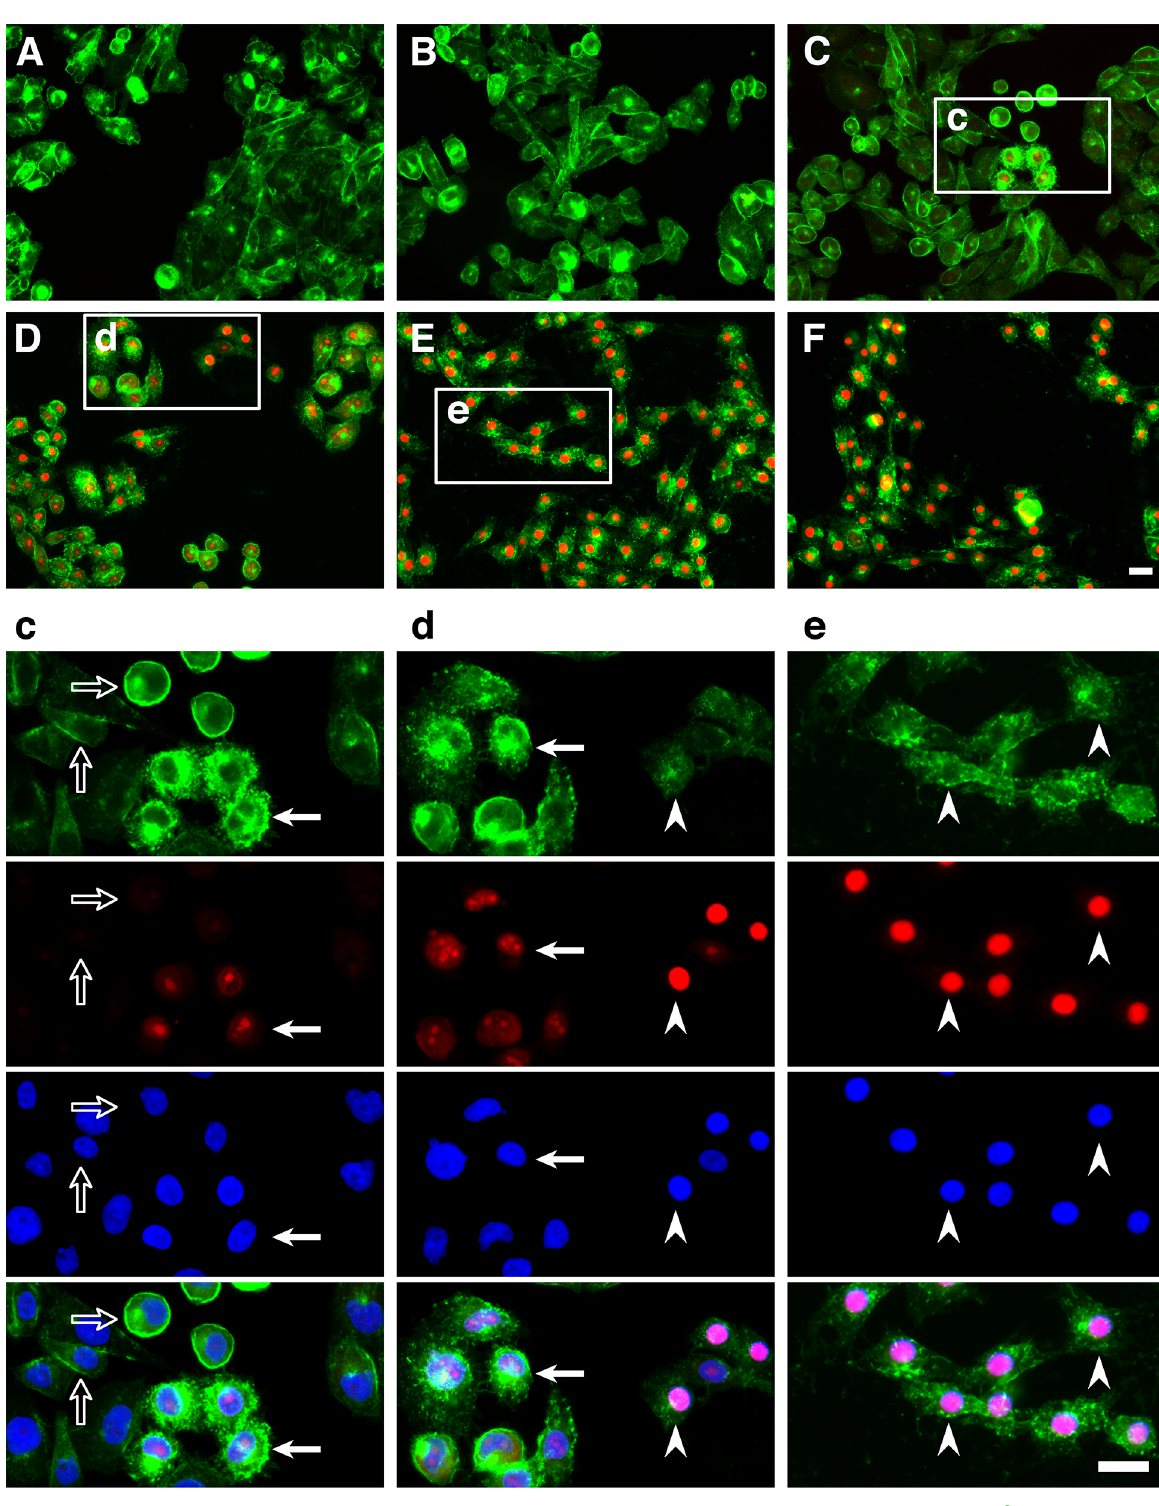
Fig 2. ETX induces rapid internalization of rMAL that precedes or coincides with cell death. CHO cells stably expressing GFP-rMAL (green) were treated with 50 nM ETX in the presence of 2 μ g/ml PI (red) and fixed at 0 minutes ( A ), 5 minutes ( B ), 15 minutes ( C ), 30 minutes ( D ), 60 minutes ( E ), and